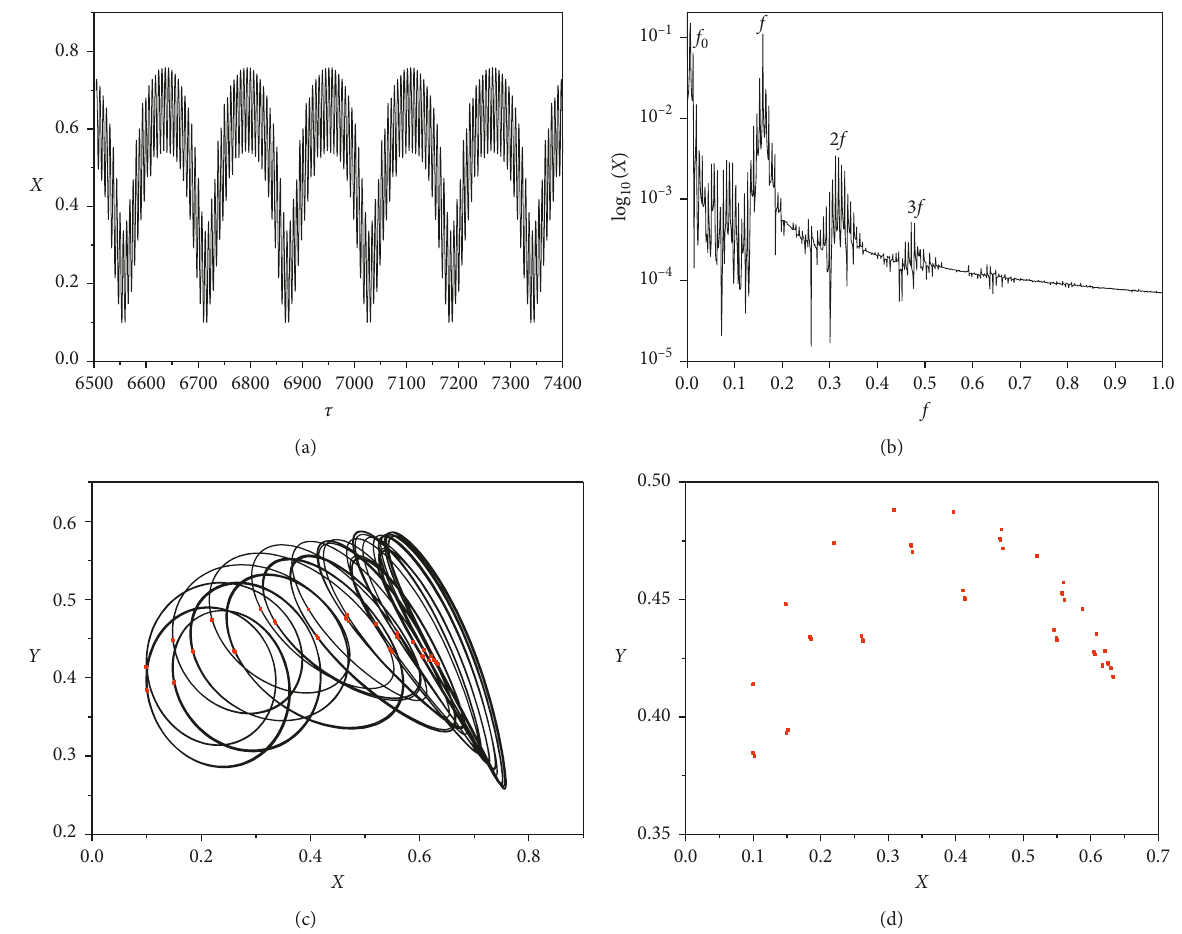
Figure 11: (a) Displacement. (b) Frequency response. (c) Rotor orbit. (d) Poincar´e map where